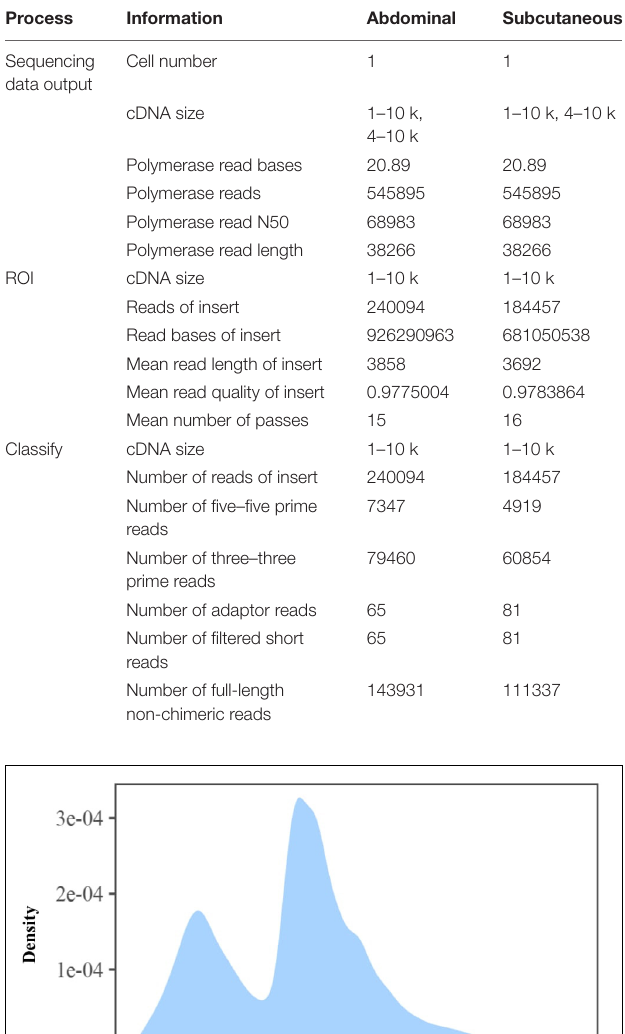
TABLE 1 | Full length transcript data information.